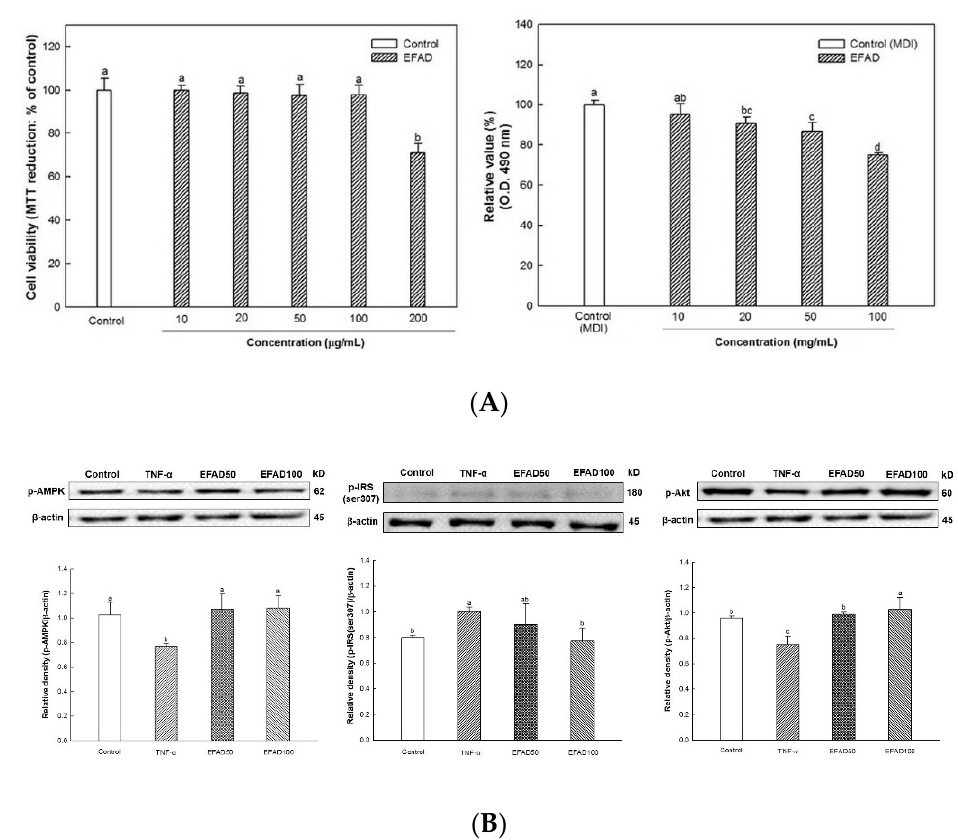
Figure 1. E ff ects of ethyl acetate fraction from Aruncus dioicus var. kamtschaticus (EFAD) against cytotoxicity, lipid accumulation, and insulin resistance on 3T3-L1 cell. ( A ) Cell viability by MTT assay and degrees of lipid accumulation by Oil Red O staining method. ( B ) Expression degrees of phosphorylated-AMP activated kinase (p-AMPK), phosphorylated-insulin receptor substrate (p-IRS) (ser307), and phosphorylated-protein kinase B (p-Akt) on Tumor necrosis factor alpha (TNF-a). The values shown are as mean ± SD ( n = 3; “ n ” means the technical repeats). The data were statistically considered at p < 0.05 and were represented as di ff erent small letters.